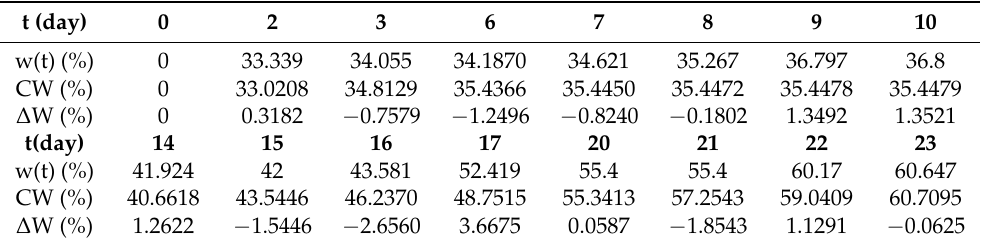
Table 3. Results obtained using the experimental data presented previously